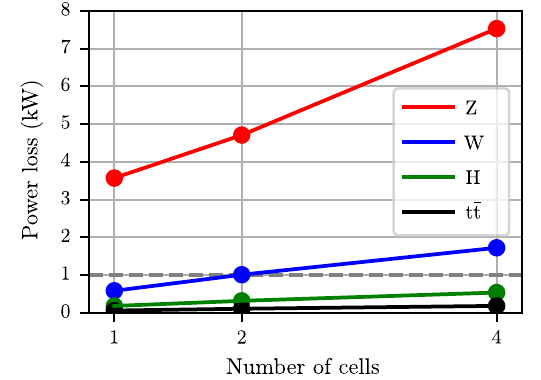
FIG. 12. Power losses for cavities with different number of cells in FCC-ee machines. The horizontal dashed line indicates the maximum power which can be extracted by a single HOM coupler.